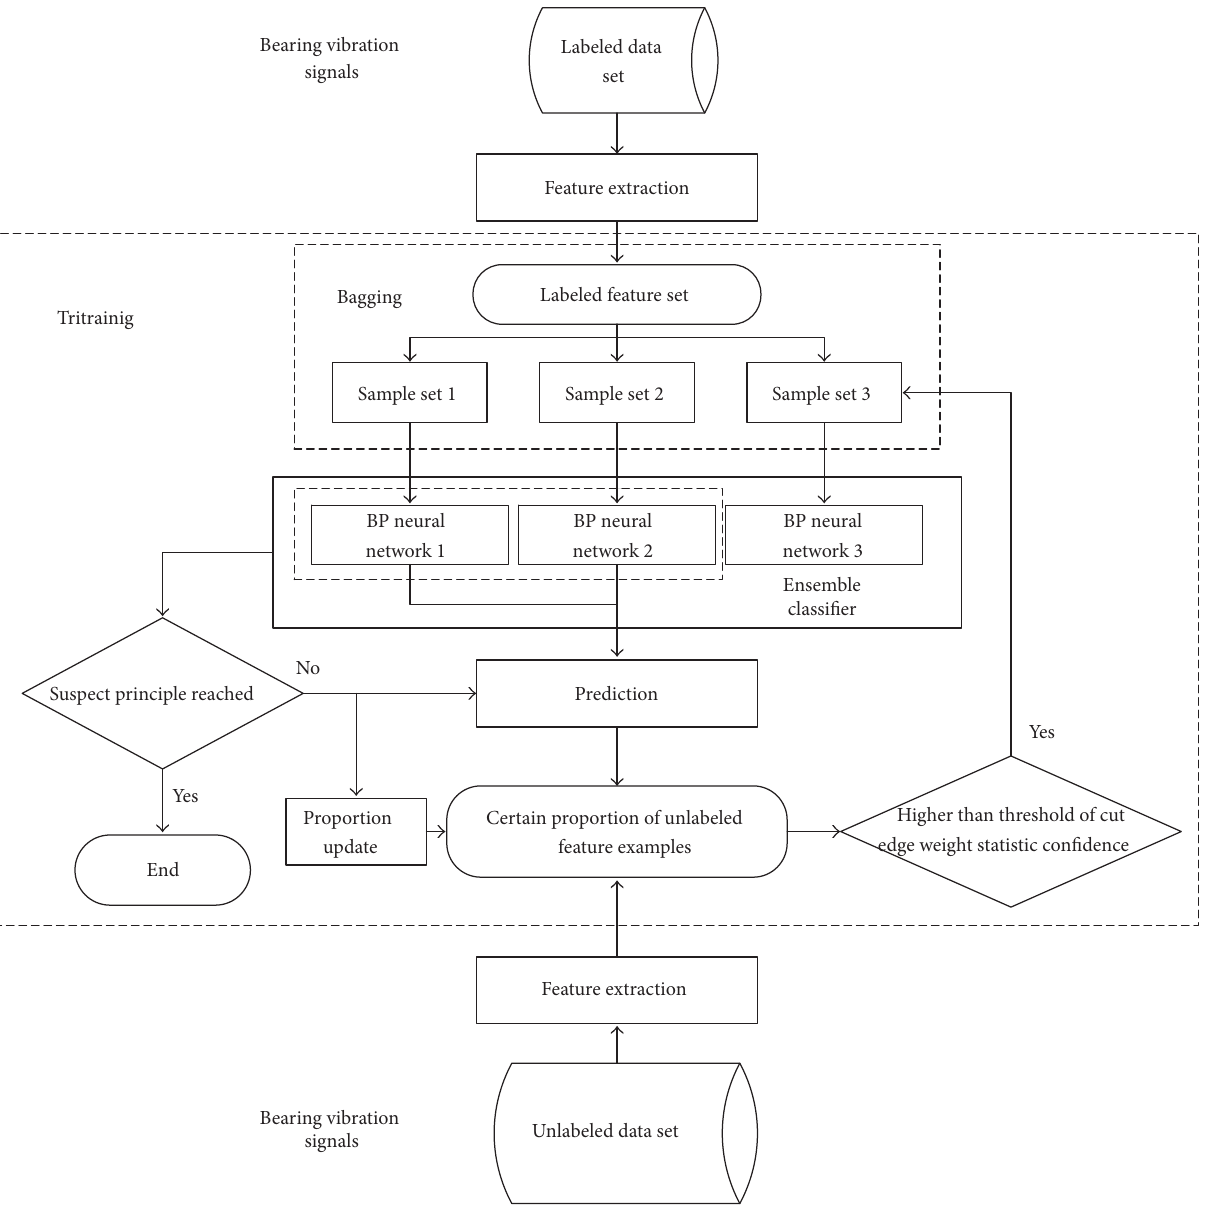
Figure 2: Framework of the proposed